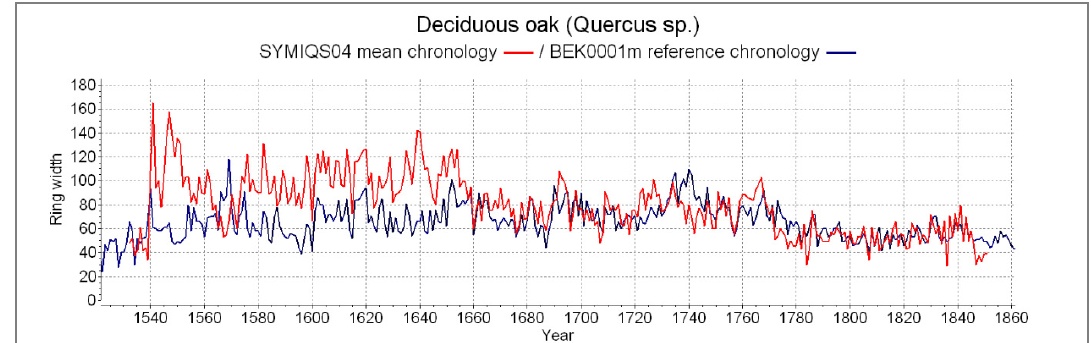
Figure 6. Visual cross-matching of the oak chronology (SYMIQS04, in red) with deciduous oak chronology from Bekedemirköy in Turkey (BEK0001m, in blue) [39]. Only the overlapping period of the two chronologies is presented here.